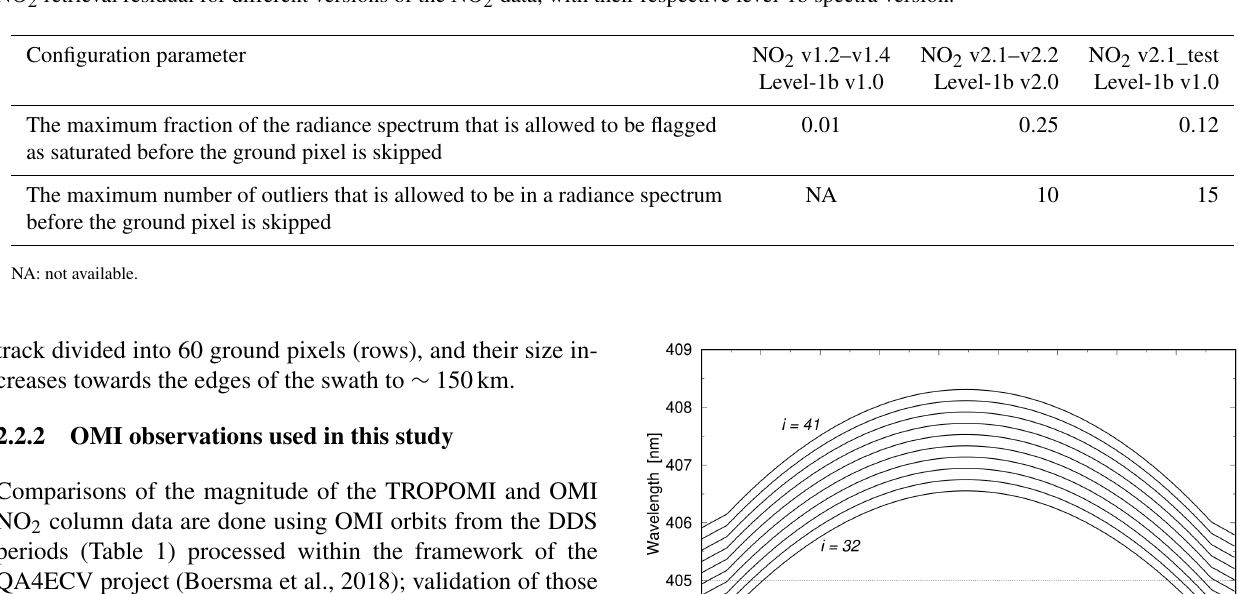
Table 2. Configuration parameters in the NO 2 processing related to saturation in the level-1b radiance spectra and removal of outliers in the NO 2 retrieval residual for different versions of the NO 2 data, with their respective level-1b spectra version.